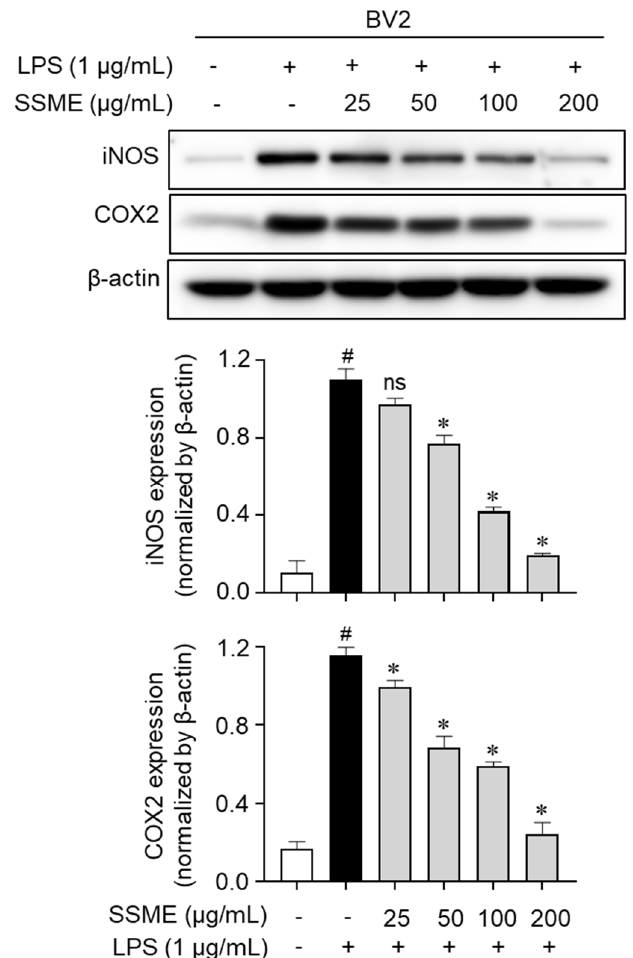
Figure 4. Effects of the SSME on the iNOS and COX-2 expression in the BV2 cells. The BV2 cells were treated with SSME (50, 100, and 200 μ g/mL) for 2 h, followed by stimulation with LPS (1 μ g/mL) for 24 h. After stimulation, the iNOS and COX-2 protein levels were analyzed by western blotting. The data are presented as the mean ± SEM of three independent experiments. Differences between the groups were analyzed using the Mann–Whitney U test. # p < 0.05, compared with the untreated and the LPS-treated groups; * p < 0.05, compared with the LPS-treated and SSME- and LPS-treated groups; ns, not significant. iNOS, inducible nitric oxide synthase; COX-2: cyclooxygen- ase-2, SSME: Symplocos sumuntia Buch.-Ham. ex D. Don. methanol extract; LPS: lipopolysaccharide.